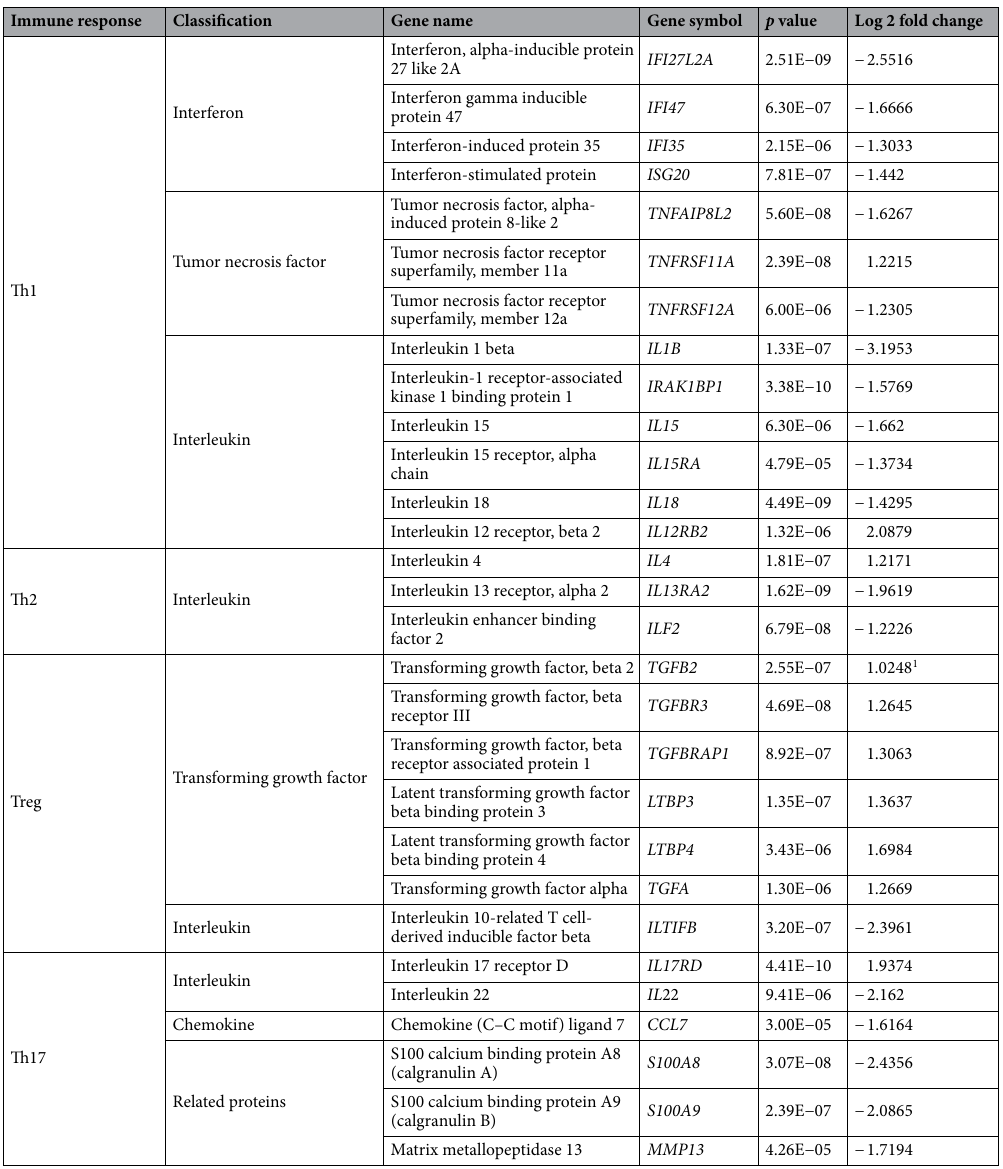
Table 4. List of differentially expressed cytokine related genes classified by immune response in the pup brain, in response to maternal H. bakeri infection. Differential regulation as reported by Haque et al. 12 . 1 Borderline significant